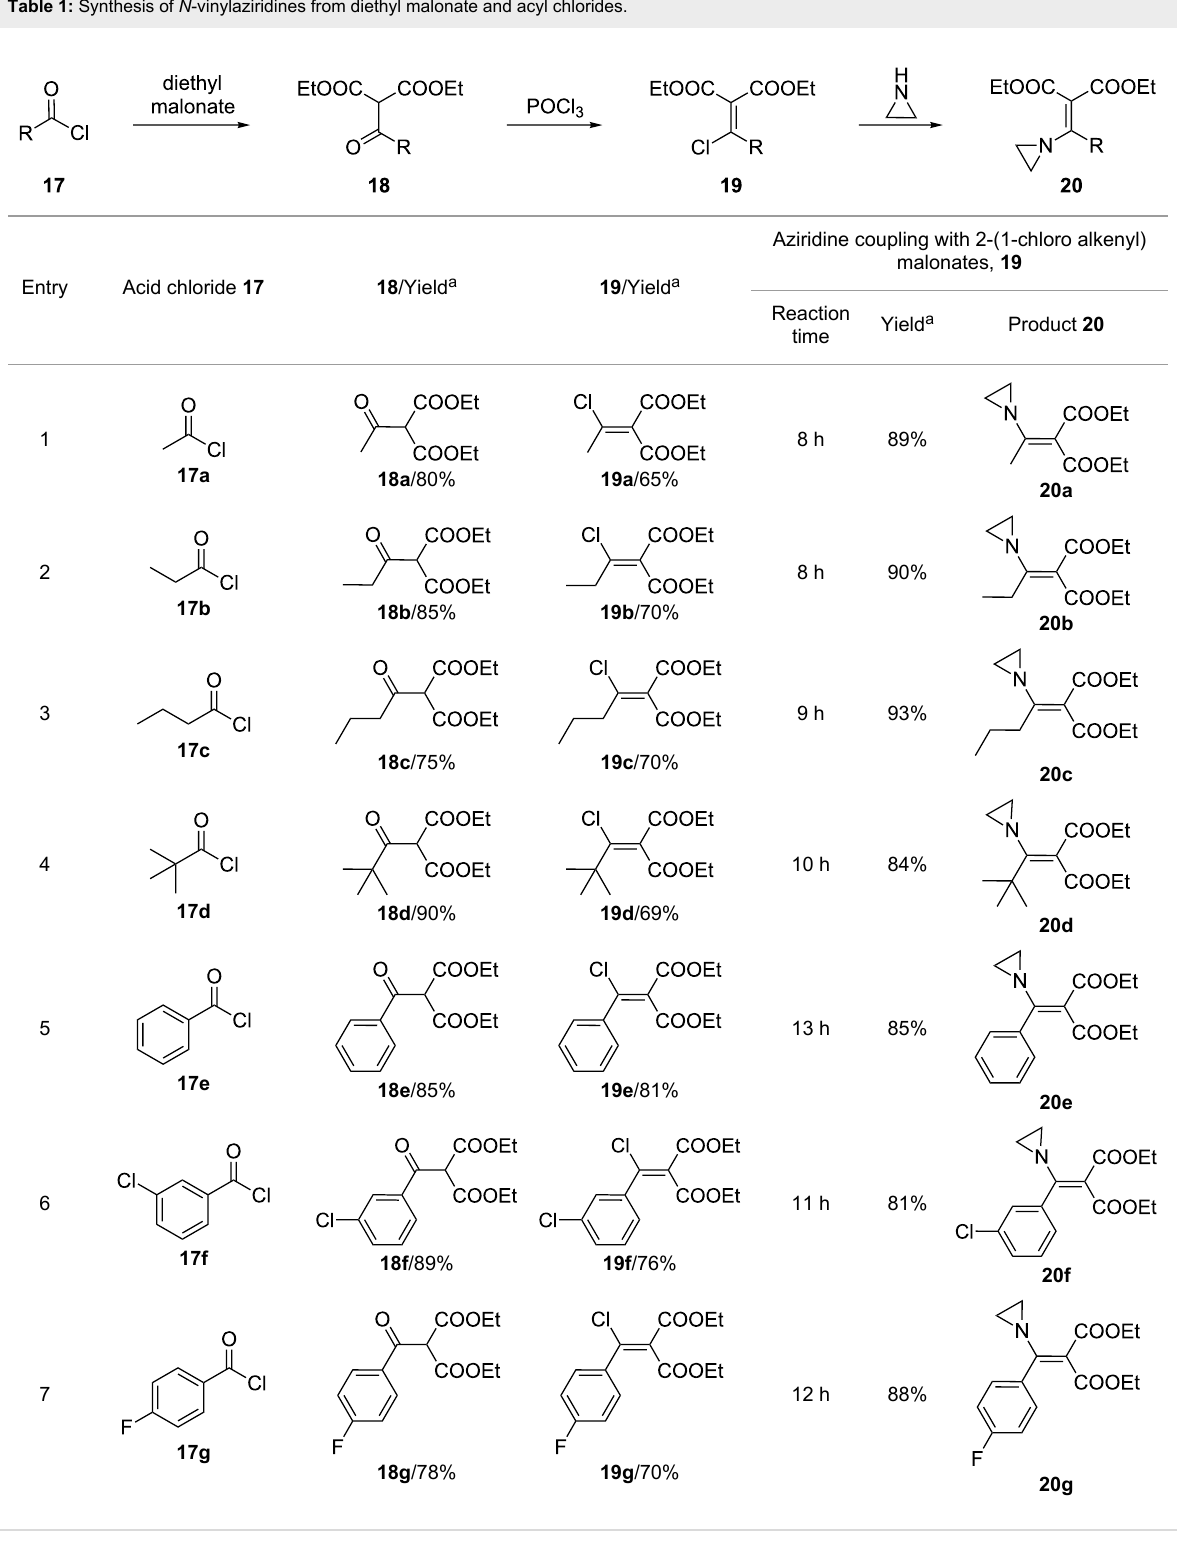
Table 1: Synthesis of N -vinylaziridines from diethyl malonate and acyl